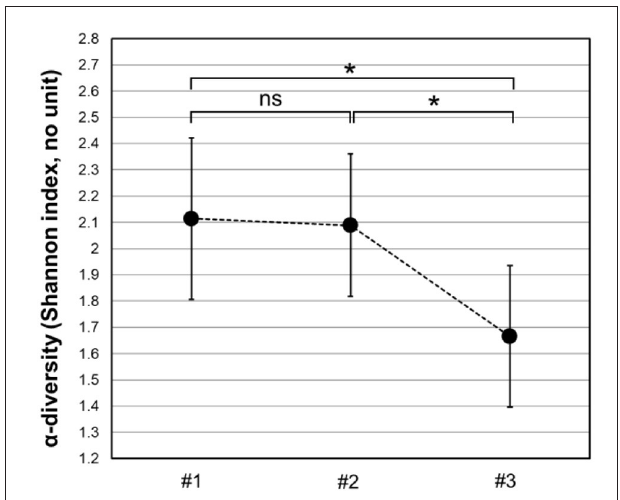
FIGURE 2 | Changes in the microbiome diversity over time and drastic effects on its relative diversity within bacterial families upon the dietary fiber consumption. The Shannon index expressed as a measure of the incidence and frequency of bacterial families in the test samples, ranged from 2.11 (#1) to 2.08 (#2), which was not a statistically significant difference ( p -value > 0.05, Hutcheson’s modified t -test, denoted ns —not significant). One month after consumption of the fiber mixture, the Shannon index dropped to 1.67, which was a significant decrease in the family diversity values ( p -value < 0.05, Hutcheson’s modified t -test, denoted by *). Error bars represent 95% CI for the calculated Shannon index. y -axis—Shannon index, without units. x -axis—sampling times. #1, time point week 1 (baseline); #2, time point week 27 (high training and competition period); #3, time point week 31 (after 30 days of dietary supplement